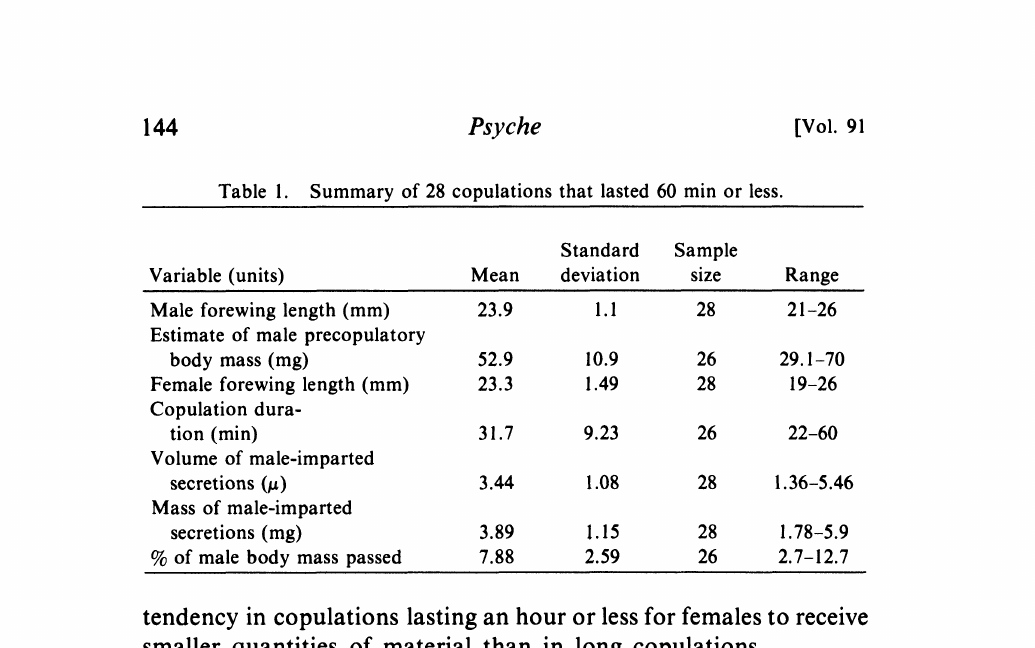
Table 1. Summary of 28 copulations that lasted 60 min or